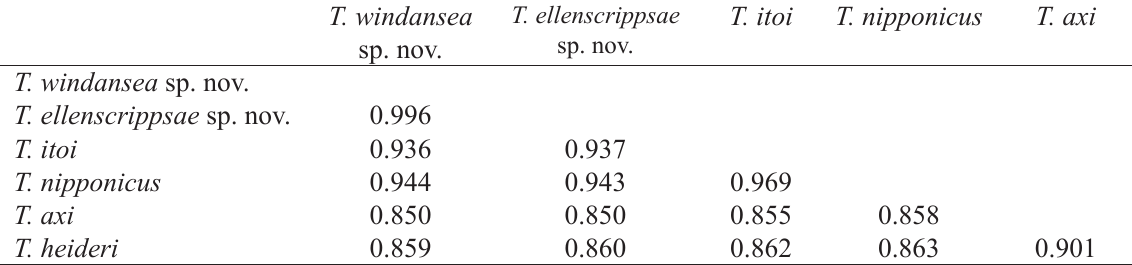
Table 5. Comparison of similarities between 28S gene fragments in species of Trilobodrilus Remane, 1925. For accession numbers of the used sequences see Table 3.